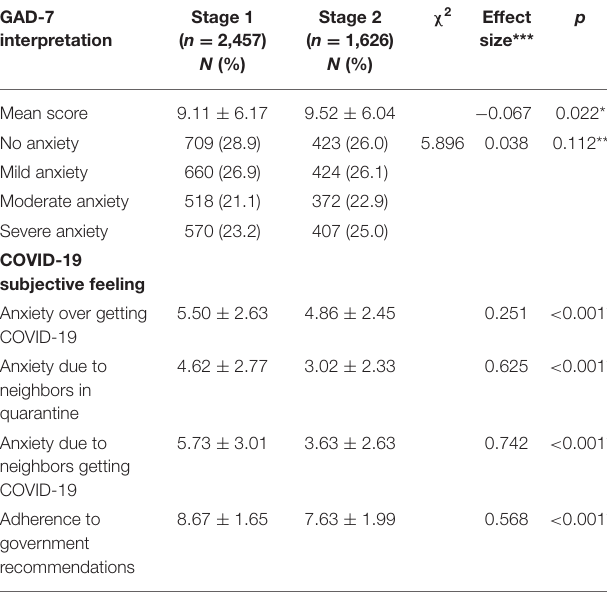
TABLE 1 | Characteristics of the study group by study stage and the results of analyses comparing the two assessments. Variable